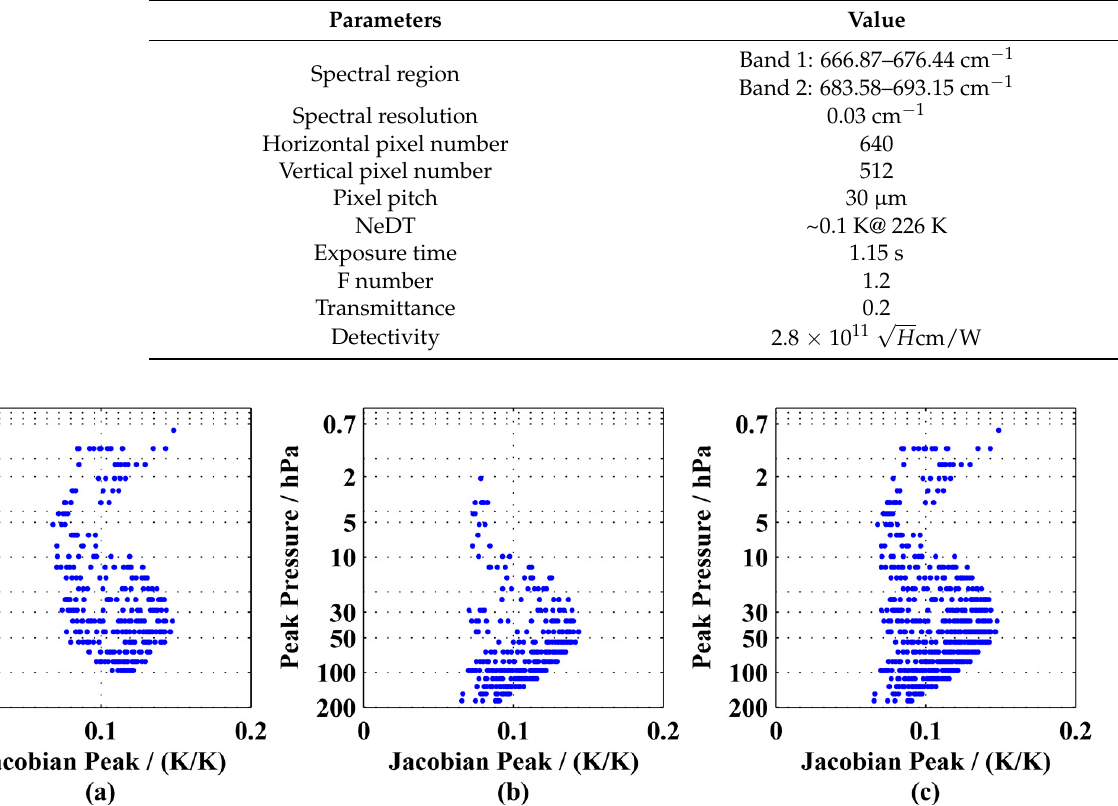
Figure 14. The temperature Jacobians peak corresponding to atmospheric pressure. ( a ) The spectral region of 666.87–676.44 cm − 1 . ( b ) The spectral region of 683.58–693.15 cm − 1 . ( c ) The combination of the two spectral regions.